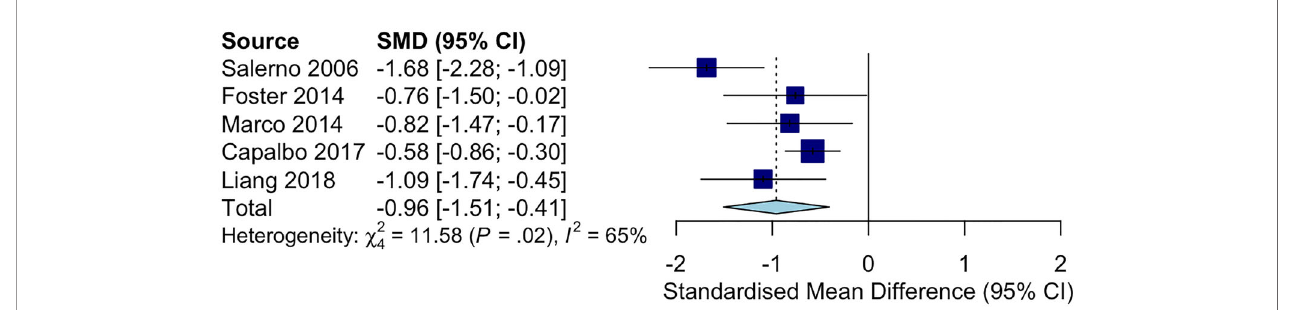
FIGURE 4 | Forest plot comparing D LDL-C in GHD patients treated with rhGH v.s. controls not receiving any treatments. ( D LDL-C = LDL-C at the end point - baseline